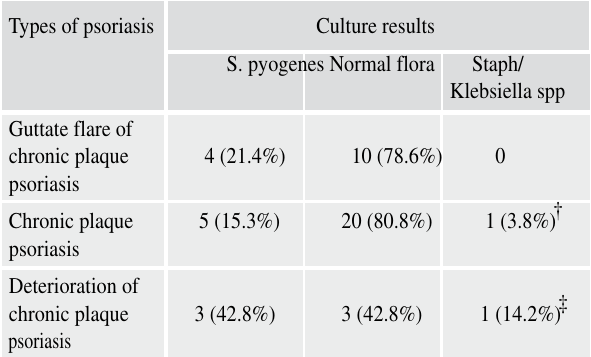
Table V: Results of throat swab culture in different types of psoriasis